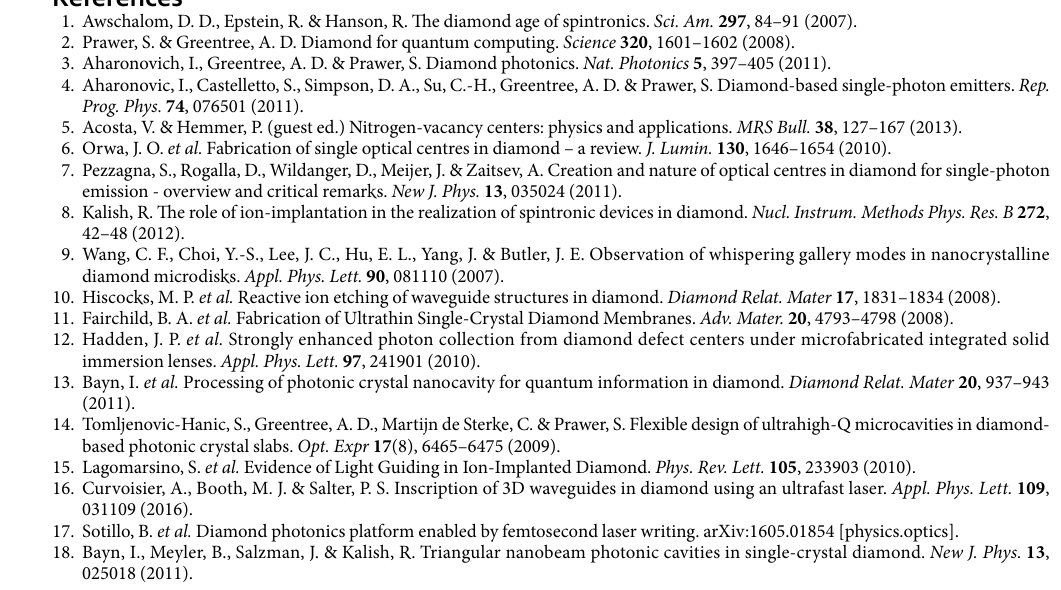
sizes between 1 μ m and 10 μ m over ~125 × 125 μ m 2 areas to deliver a homogeneous fluence over the central area of each irradiated region 23 . While the former implantation run was conducted under high-vacuum conditions, the latter one was performed by extracting the ion beam in standard atmosphere. In both cases, the sample was kept at an angle of ~5° with respect to the direction of the incident beam, to avoid channeling effects. Typical ion currents were in the 0.1–1.0 nA and 0.5–1.5 nA ranges for 3 MeV H + and 5 MeV H + irradiations, respectively. For 3 MeV H + irradiations, the fluence was estimated by directly measuring the ion current with a Faraday cup prior to each irradiation and consequently timing each irradiation time; care was taken to measure the ion current after each irradiation, to check the beam current stability. For 5 MeV H + irradiation, fluence calibration was performed by preliminarily correlating the ion current measured with a Faraday cup with the yield of ion-beam-induced characteristic X-rays from the exit window of the external beam, and subsequently by monitoring the X-ray yield during irradiation (see refs 23 and 46 for further details). After ion implantation, the sample was not subjected to any post-processing procedure, due the extreme fragility of both the diamond layer and its mounting on the supporting metallic frame. As schematically shown in Fig. 6 and reported in further experimental details in ref. 23, a λ = 632.8 nm probe beam from a He-Ne laser was employed in conjunction with a 20 × micro-Fizeau objective. By means of the phase-shift method 47 , the relative phase of the test beam crossing the sample with respect to the reference beam was reconstructed at each pixel with a lateral spatial resolution better than 2 µ m and with a field view of 349 × 317 μ m 2 . It is worth noting that the sample was mounted in a tilted position to reduce the effects of unde- sired internal reflections between the two opposite surfaces of the sample.